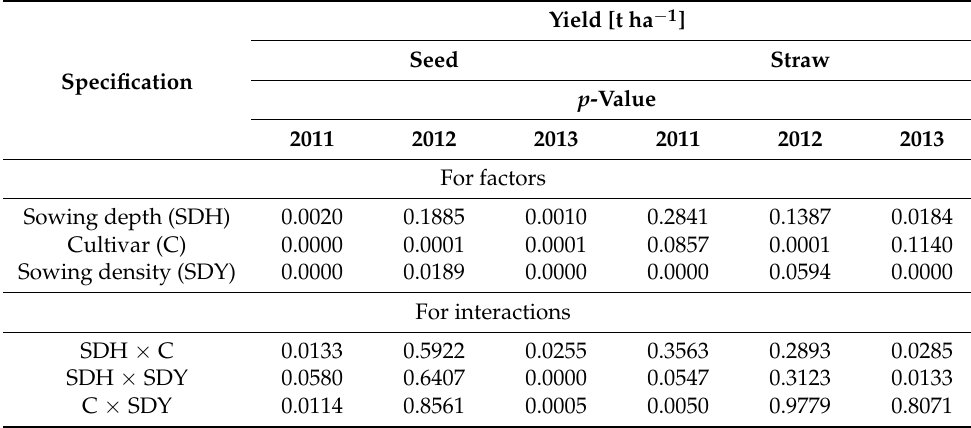
Table 6. Effect of examined factors on the seed and straw yield of faba bean [t ha − 1